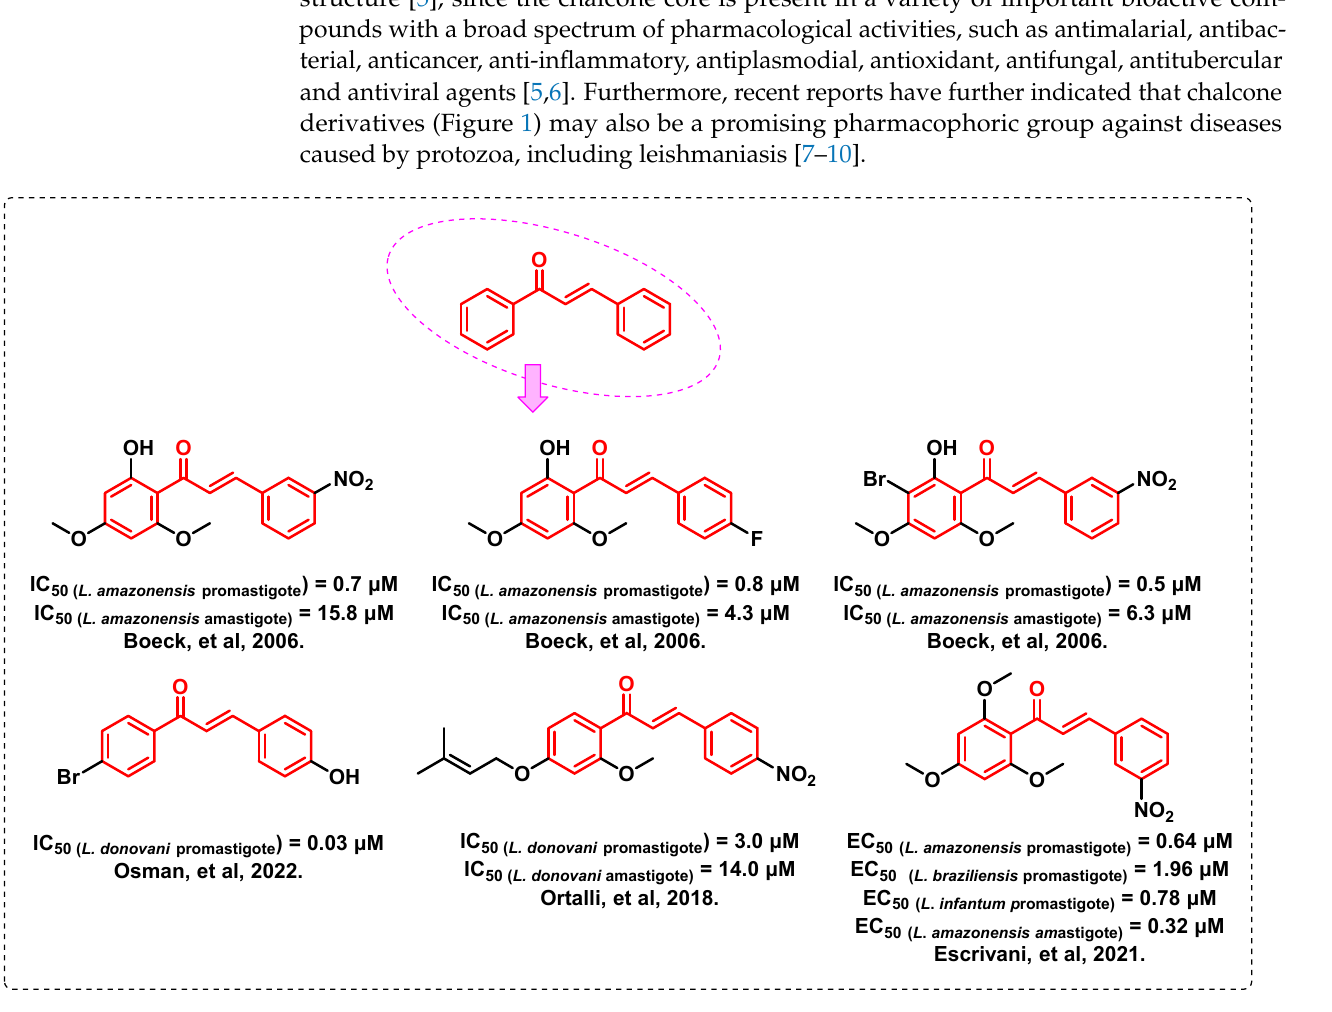
Figure 1. Chalcones with promising antileishmanial activity [7–10].